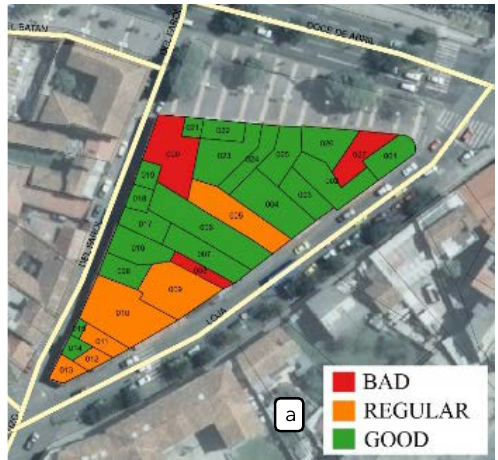
Figure 3: a) Before the Campaign (2012) b) After de Campaign (2014), c) monitoring (2016), d) monitoring (2017) Source: vlirCPM